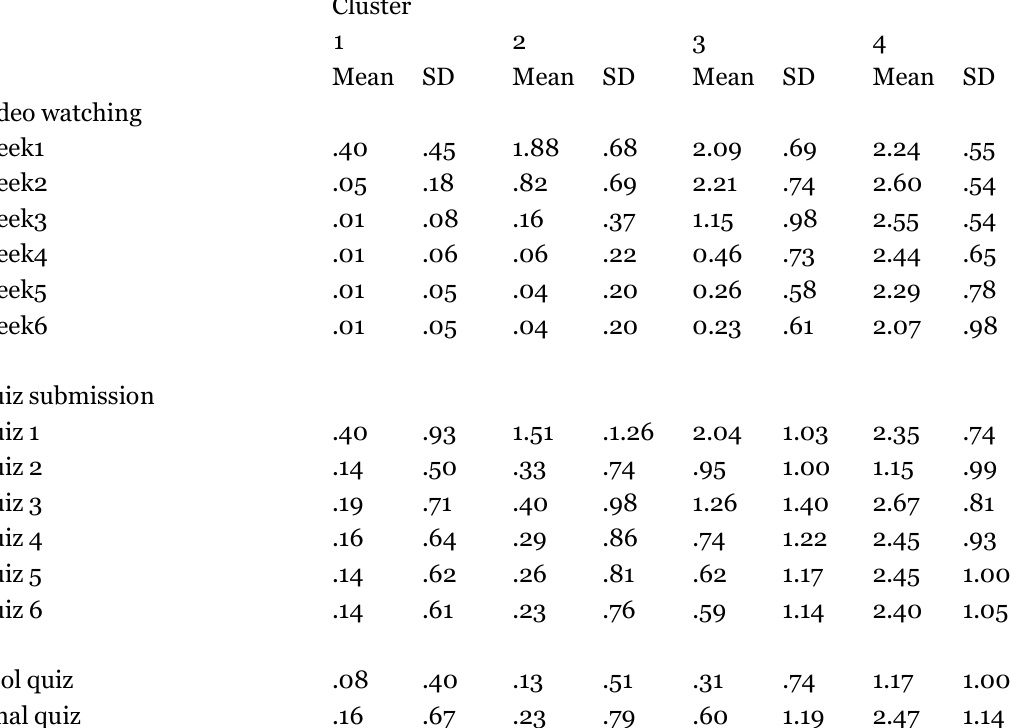
Mean Video Watching Scores and Quiz Submission Scores (and SD) per